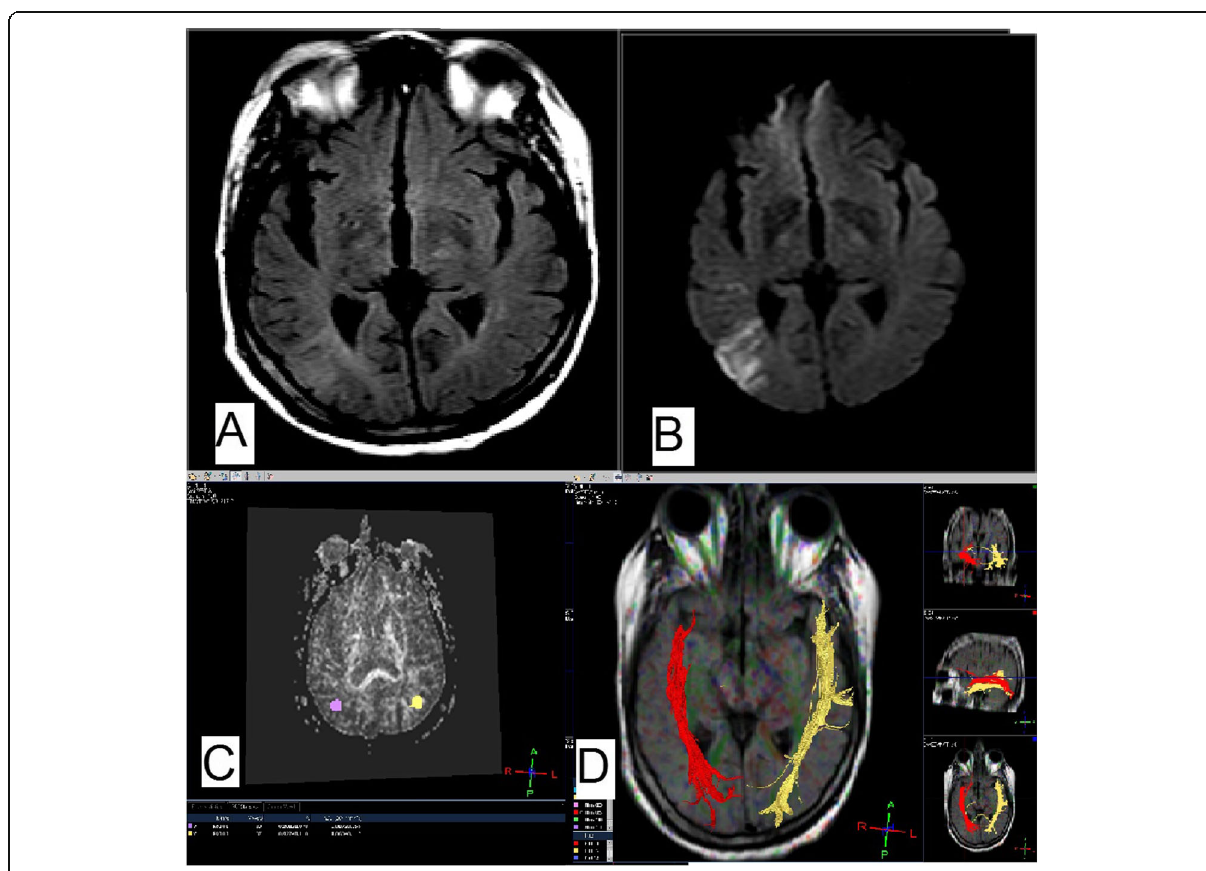
Fig. 5 A 50-year-old male patient, diabetic and hypertensive, presented with DCL. NIHSS on admission was 10 a axial FLAIR. b Axial diffusion WIs (b1000) show right occipital acute infarct. c Grey scale FA map showing reduced FA value at the site of infarct (0.2) compared to the contralateral normal side (0.3) d axial FA color-coded map overlaid over axial FLAIR image with 3D fiber tractography of the inferior longitudinal fasciculus that appear preserved. The patient shows significant clinical improvement with residual speech difficulties. NIHSS after 3 months was